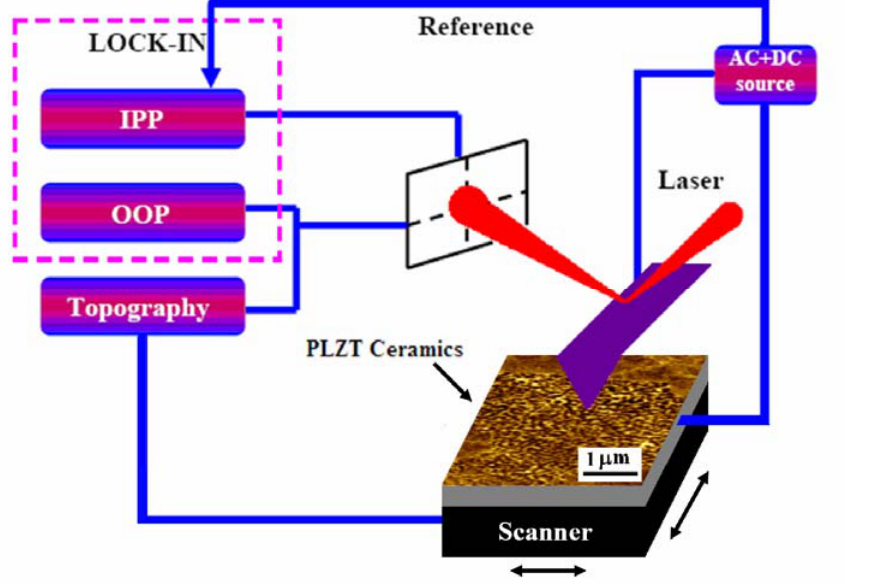
Figure 3. Schematic of the observed nanodomains (beneath the surface) and the configuration of the PFM measurements where the voltage is applied via a grounded conducting tip.